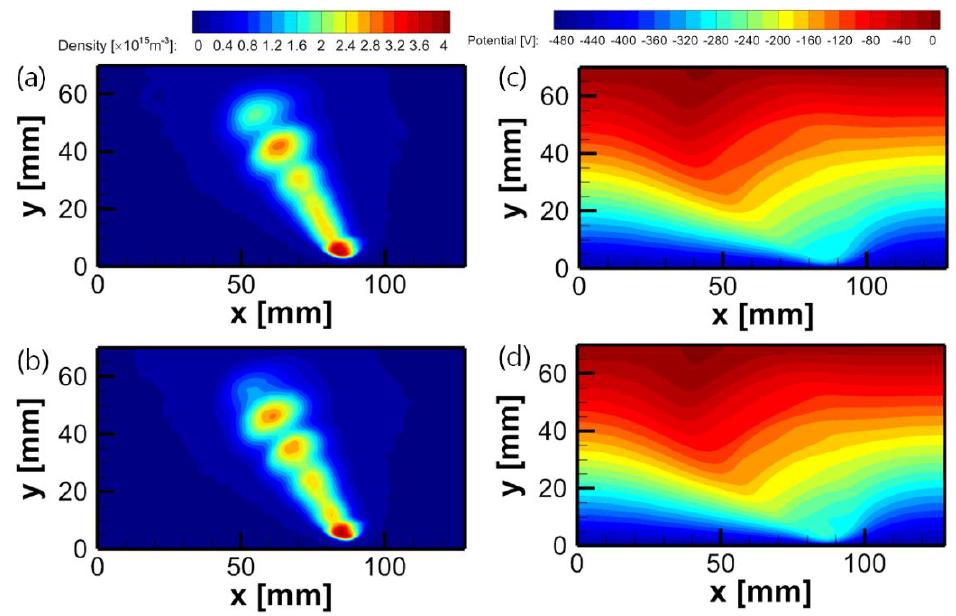
Figure 6. Plasma densities with the yoke thickness of ( a ) 10 mm and ( b ) 15 mm . Electric potentials with the yoke thickness of ( c ) 10 mm and ( d ) 15 mm .